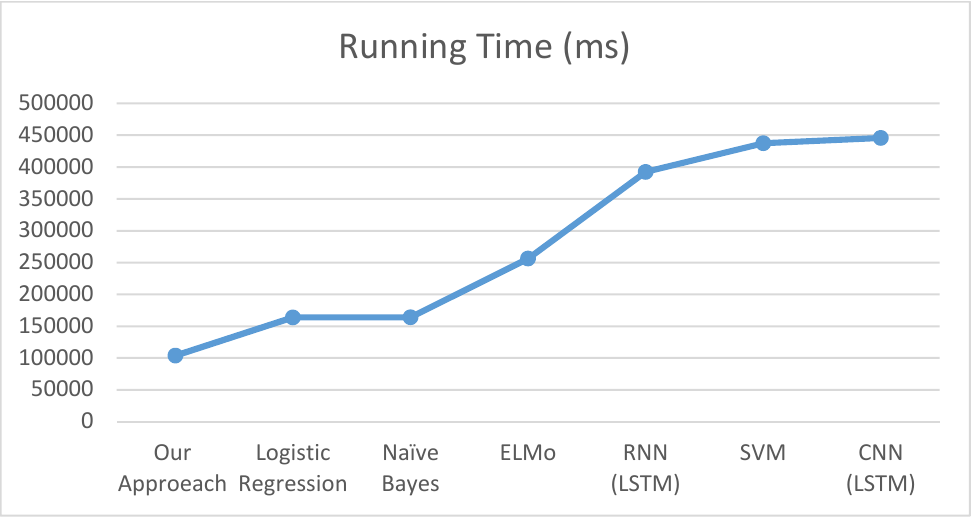
Figure 7. Time complexity for each method.